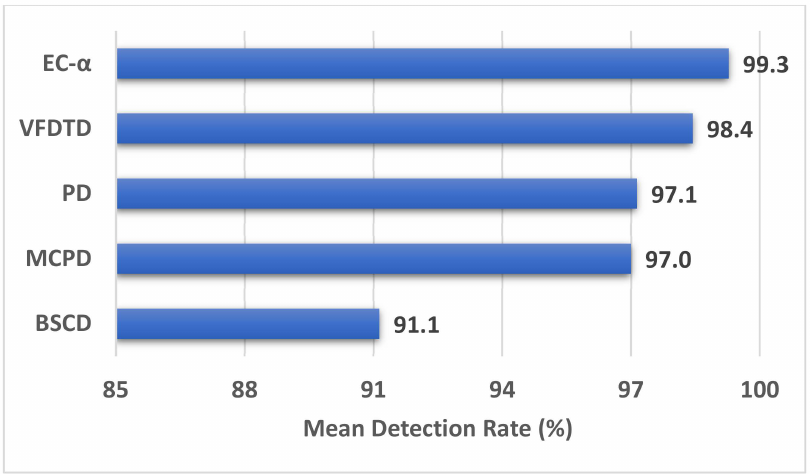
Figure 8. Overall transient starting point detection accuracy of the methods at medium SNR.